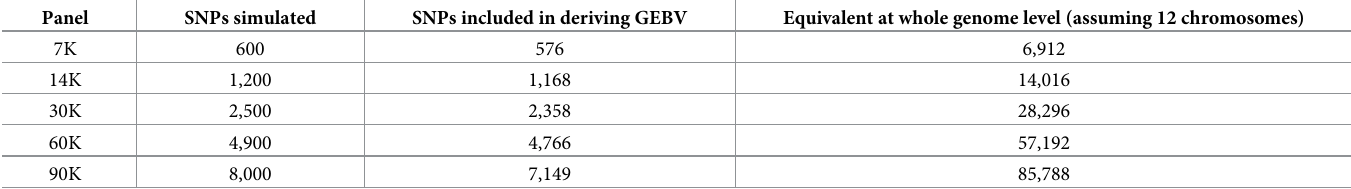
Table 2. Five SNP panels were simulated with 600, 1,200, 2,500, 4,900 and 8,000 SNPs in one chromosome, which was equvalent to 7K, 14K, 30K, 60K and 90K